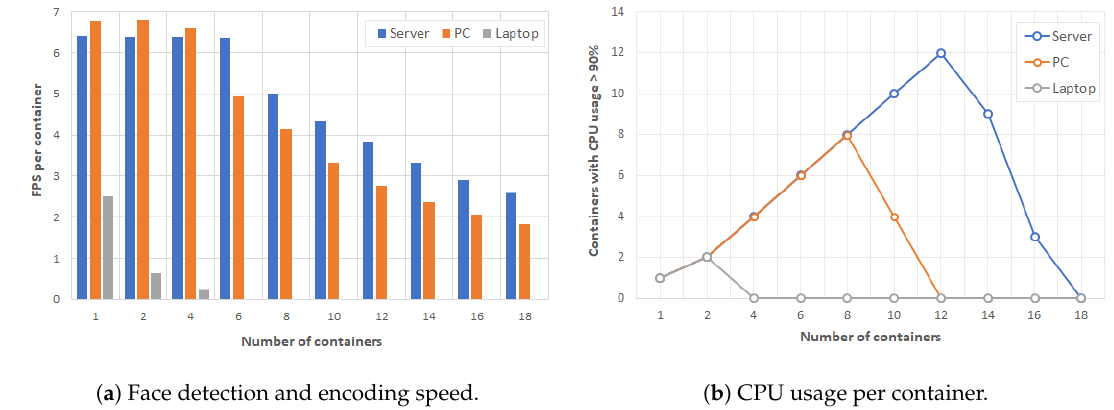
Figure 4. Performance results for Face Recognition application in Docker